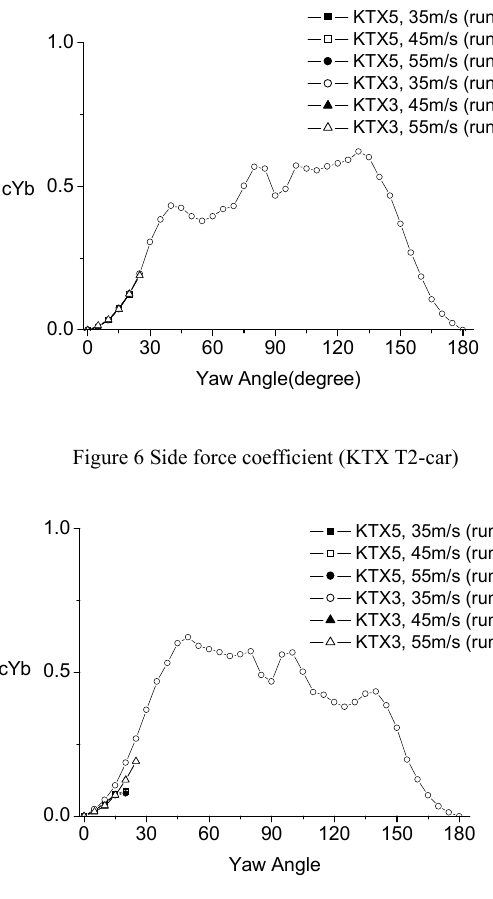
Figure 7 Side force coefficient (KTX